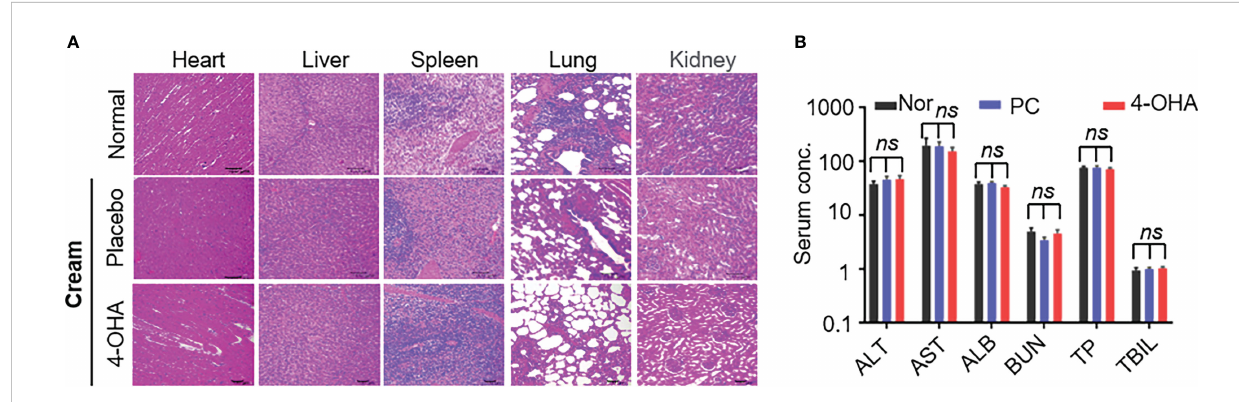
FIGURE 3 Safety evaluation of 4-OHA. Seven-week-old female SD rats were topically applied with cream at a dose of 10 g/kg. (A) H&E staining of main organs in SD rats after treatment with placebo or 4-OHA cream, or without treatment. (B) Serum biochemical parameters, including ALT, AST, TBIL, ALB, BUN, and TP, in rats treated with or without cream. Nor, normal; PC, placebo cream; 4-OHA, 4-OHA cream. There is no signi fi cance between the group of placebo cream or 4-OHA cream and normal group. p > 0.05, ns . ns means no signi fi cant